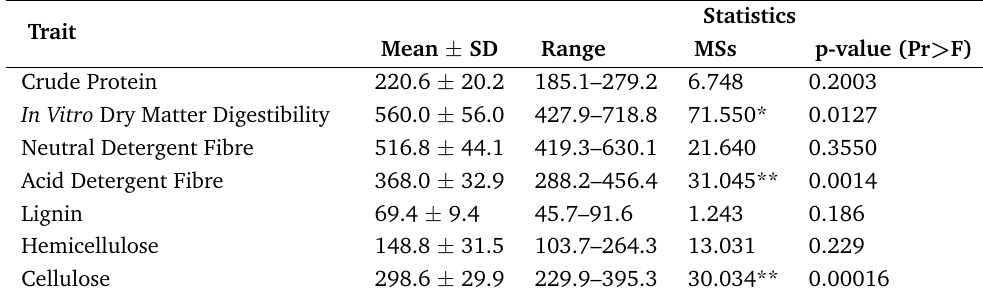
Table 2. Mean ± standard deviation (SD), minimum and maximum values (Range) in g/kg, site of collection (state) mean square (MSs), and p-value of five quality traits from 80 Stylosanthes scabra Vogel germplasm accessions. *, ** significant differences among states at 0.05 and 0.01 α levels, respectively.